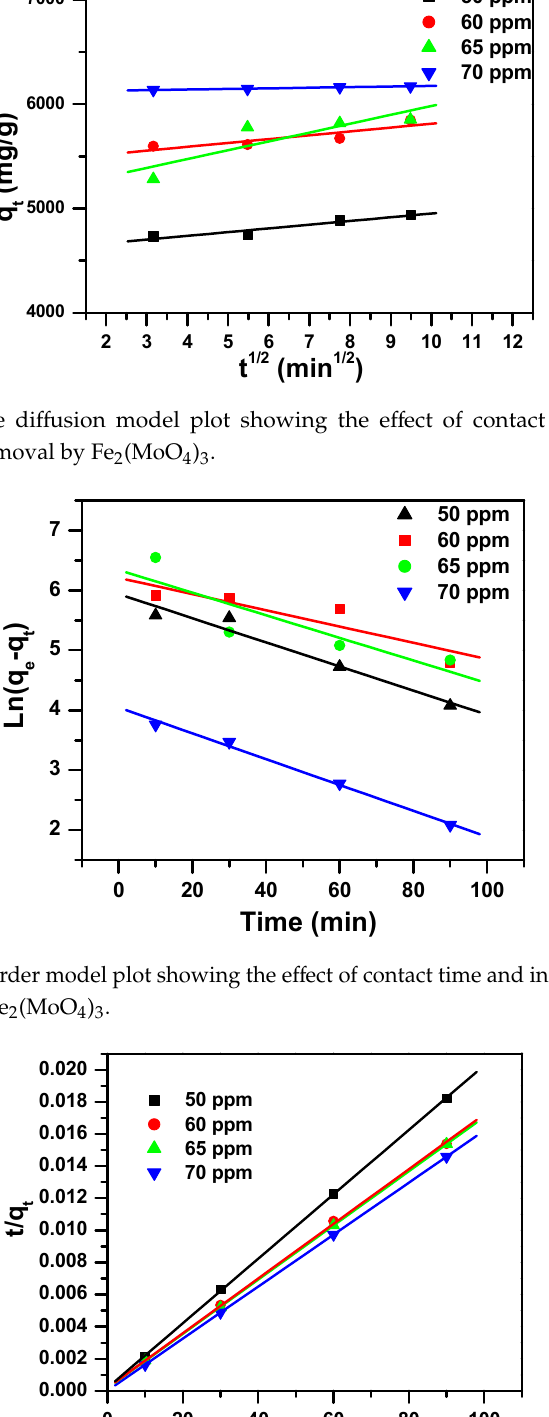
Table 4. Adsorption isotherm models for MB dye removal using Fe 2 (MoO 4 ) 3 .